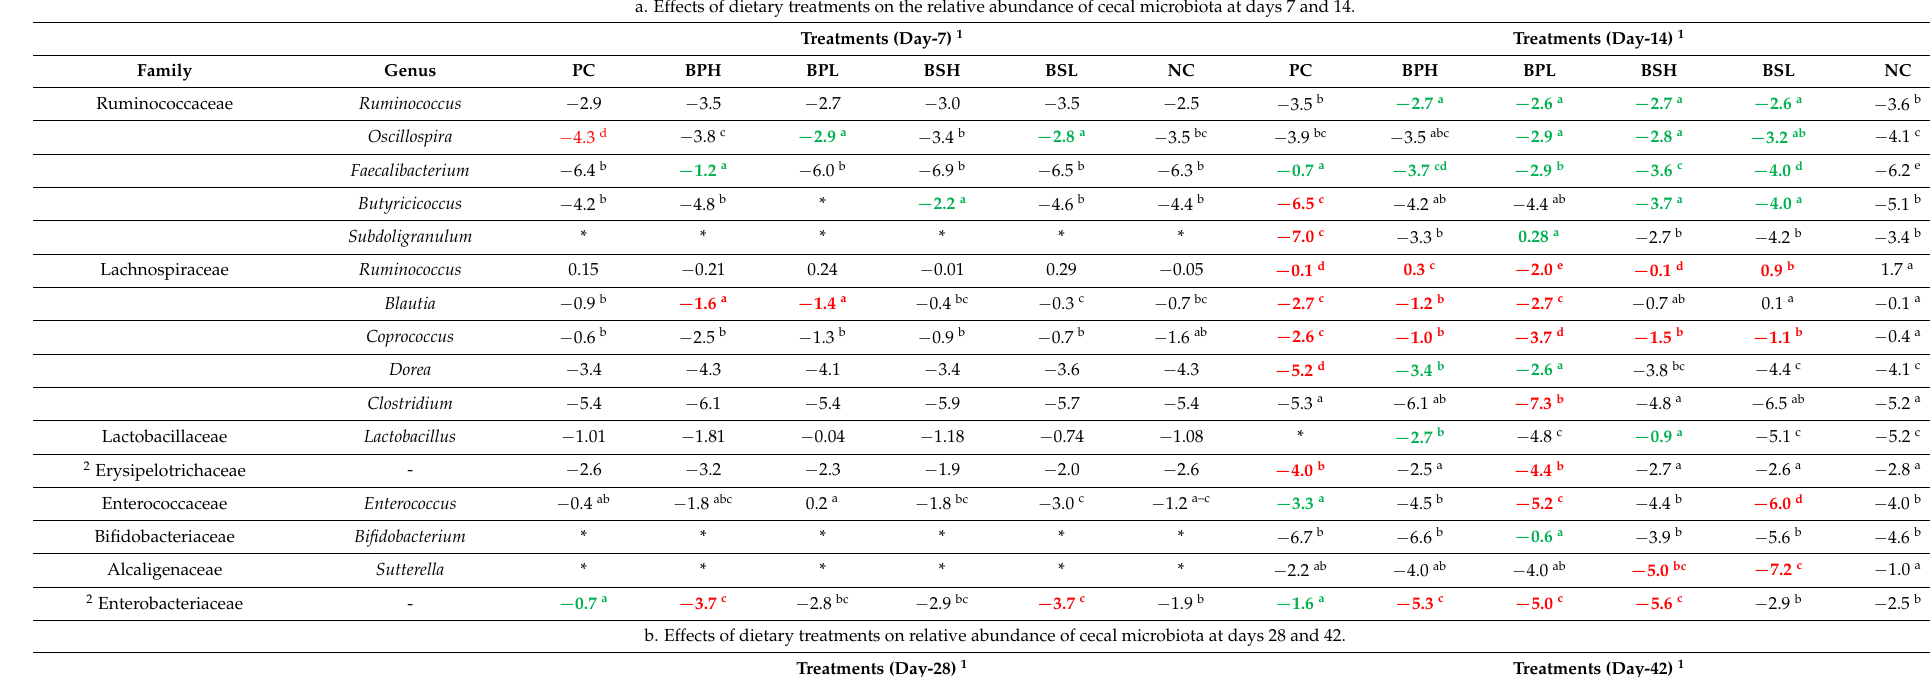
Table 3. Effects of dietary treatments on the relative abundance of cecal microbiota at days 7, 14, 28 and 42. a. Effects of dietary treatments on the relative abundance of cecal microbiota at days 7 and